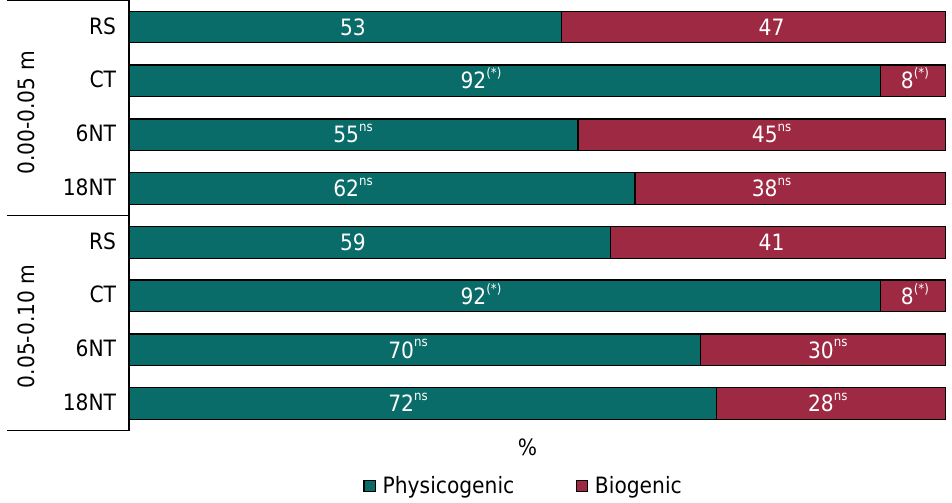
Figure 3. Distribution of physicogenic and biogenic aggregates in 0.00-0.05 and 0.05-0.10 m soil layers under different management systems in the Cerrado region of Uberaba, Minas Gerais, Brazil. An asterisk (*) indicates a significant difference from the reference site (Dunnett’s test, p<0.05). ns : not significant; RS: reference site, a well-preserved fragment of the Brazilian Cerrado; CT: 20-year conventional tillage site; 6NT: 6-year no-till site; 18NT: 18-year no-till